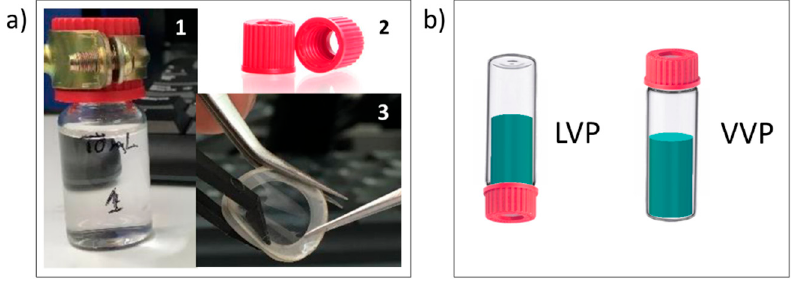
Figure 1. ( a ) 1. Glass vial with an open screw cap for water permeation measurements through Nafion films; 2. Detail of the open screw cap; 3. N212 membrane sandwiched between silicone joints for the assembly; ( b ) vials position for liquid–vapor permeation (LVP) and for vapor–vapor permeation (VVP) measurements.